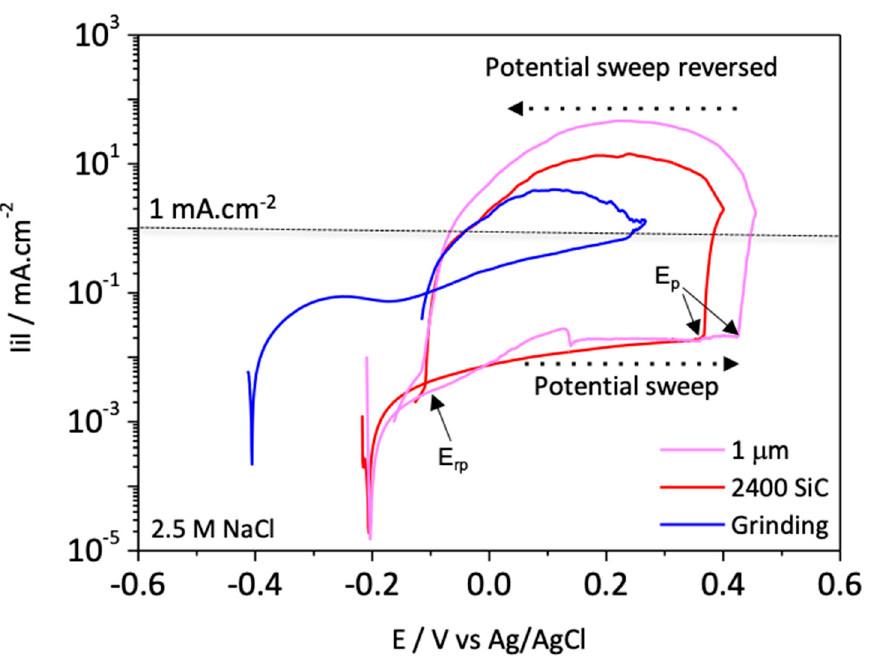
Figure 7. Cyclic potentiodynamic polarization (CPP) curve 304L immersed 24 h in the buffer solution follow by immersion in 2.5 NaCl for grinding process, polished samples down to 2400 with SiC and 1 µm with diamond paste.